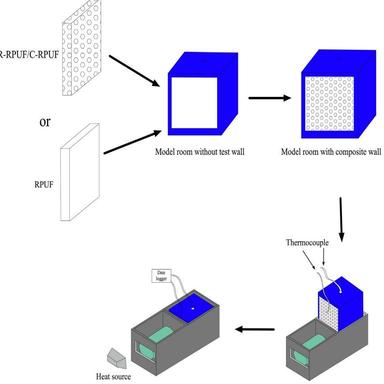
The small room model tests the temperature control performance of the composite RPUF.